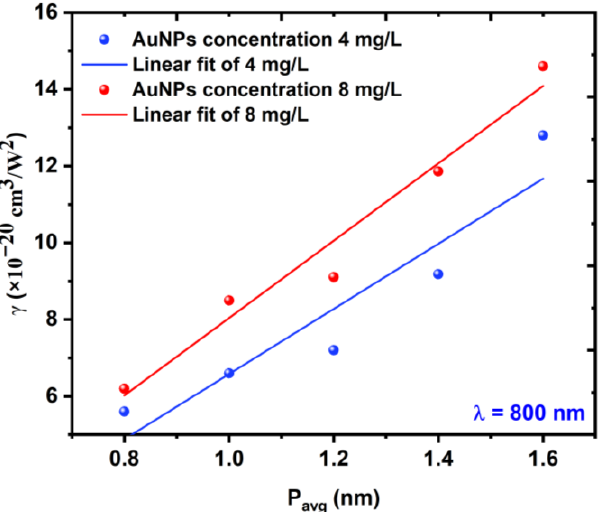
Figure 10. Variations in the NL absorption coefficient 𝛾 as a function of the average power 𝑃 𝑎𝑣𝑔 at a constant excitation wavelength of 800 nm.